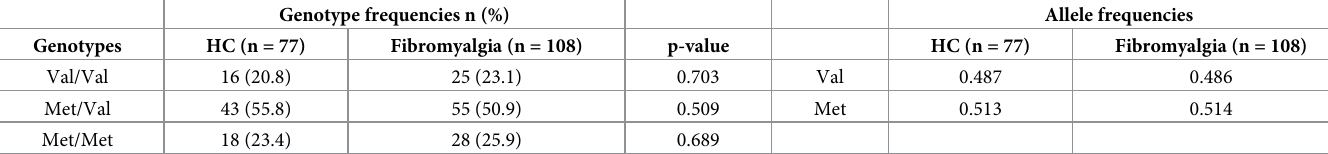
Table 1. Allele and genotype frequencies of COMT in the patients with fibromyalgia and the healthy controls participants. Genotype frequencies n (%) Allele frequencies